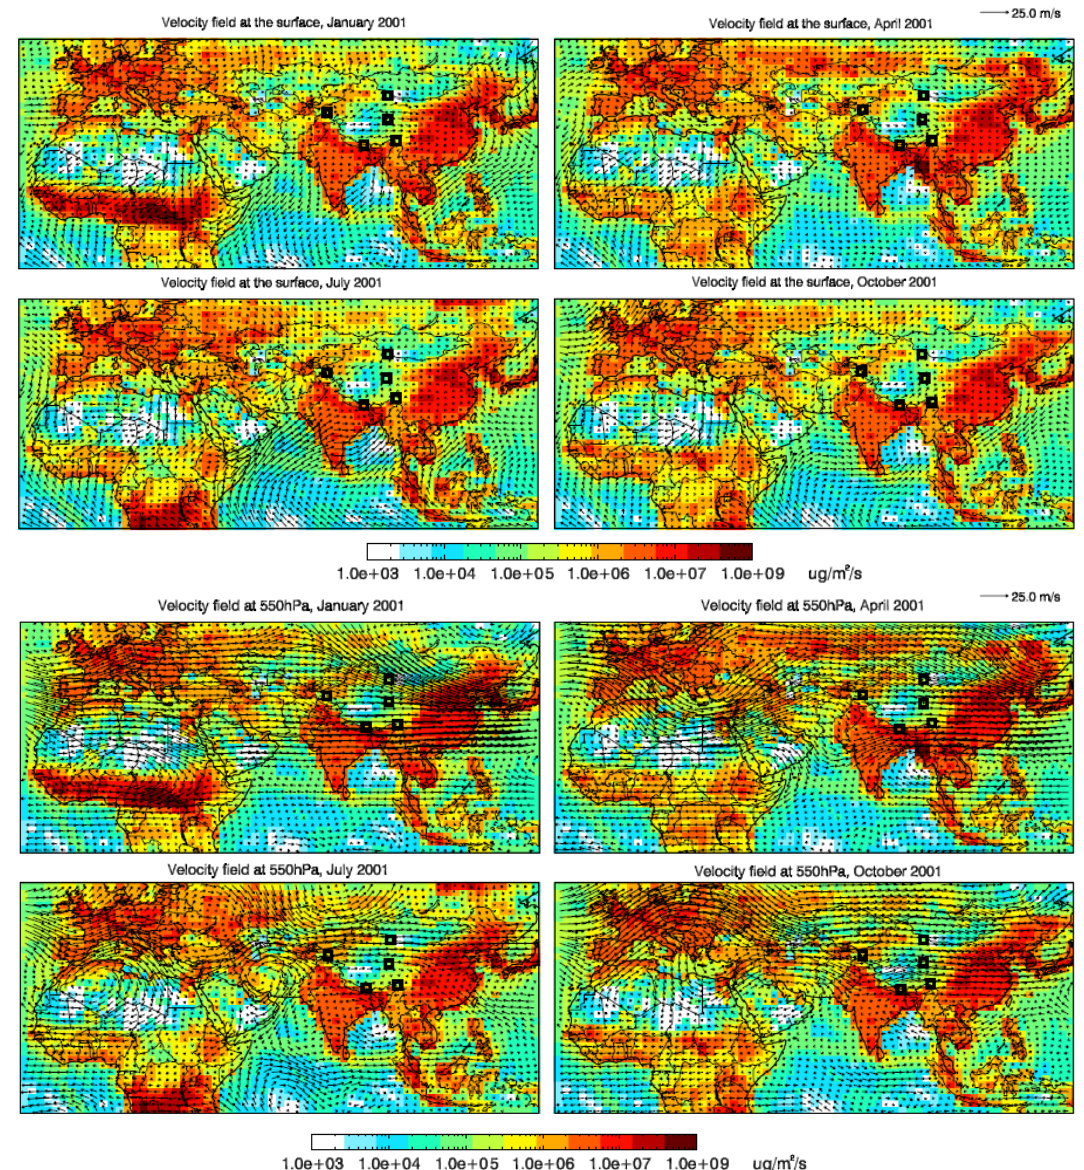
Fig. 3. Horizontal velocity fields at the surface and at 550hPa for January, April, July and October. Each plot represents an average of the first two weeks of the month, corresponding to the period used to calculate the origin of BC reaching the glaciers. Emissions of BC are overlaid in color and include seasonally varying emissions from biomass burning. Glacier sites considered here are marked with black squares.